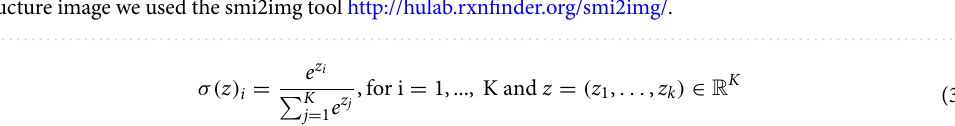
Figure 2. The seq2seq fingerprint architecture used to generate drug embeddings. For the drug’s SMILES 2D structure image we used the smi2img tool http:// hulab. rxnfi nder. org/ smi2i